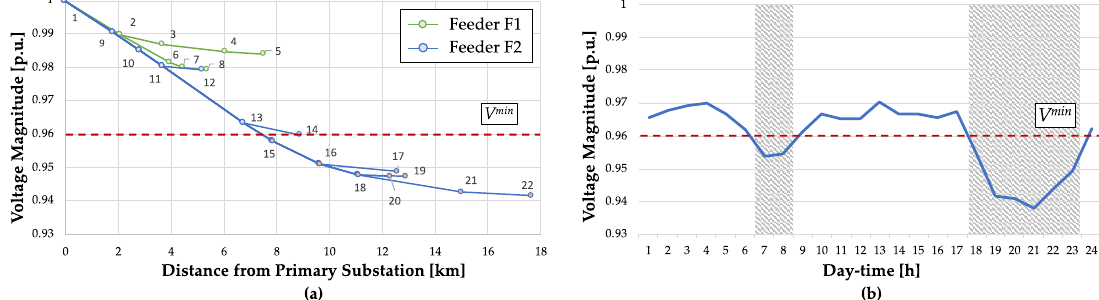
Figure 7. ( a ) Network profile of the minimum nodal voltage at the 19th hour; ( b ) Daily profile of the minimum voltage of